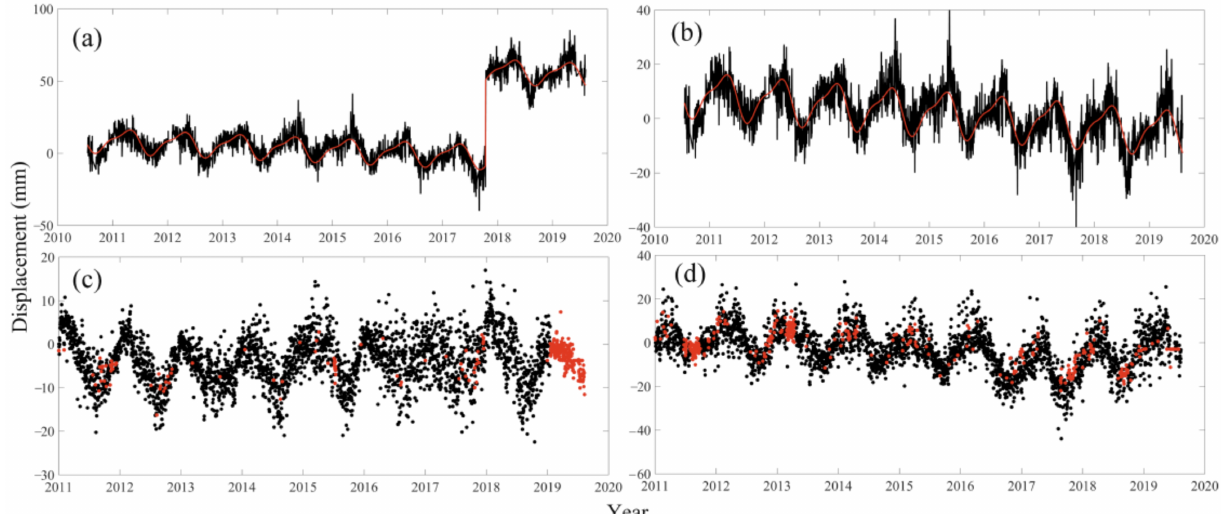
Figure 2. GNSS vertical time series of the YNRL station before ( a ) and after ( b ) position offset correction, and RegEM interpolation results for the SCDF ( c ) and SCNN ( d ) stations. The black line represents the original GNSS vertical time series of the YNRL station, the red line represents the GNSS vertical time series modeled by the LSF method, and the black and red dots represent the original GNSS vertical time series and interpolation data,